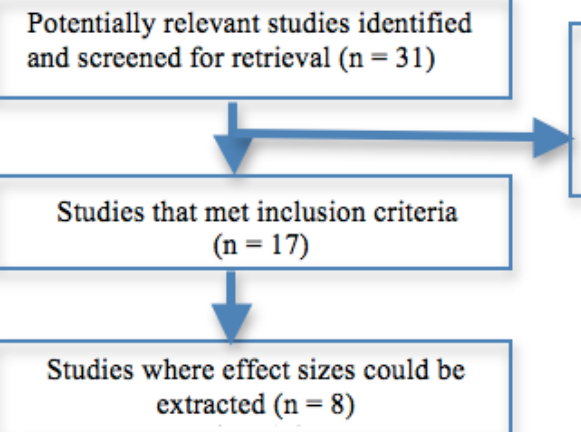
Figure 1. Study identification and analysis flow